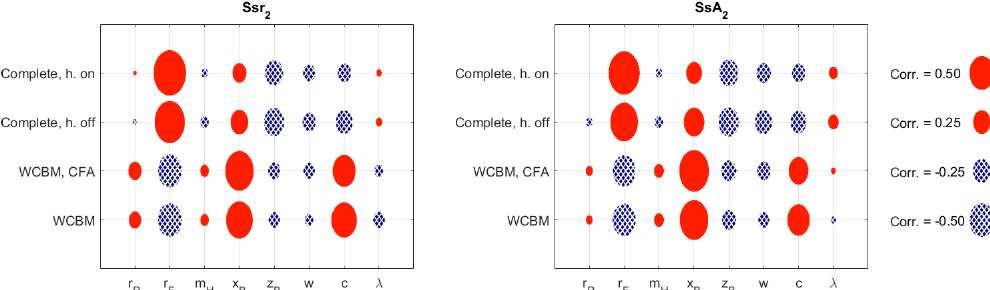
Figure 14. Correlation coefficients for the stability indices taking into account weave and capsize. Models of increasing complexity from bottom to top. Speed range: 0 to 10ms − 1 .